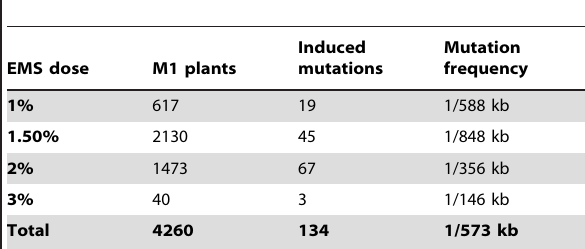
Table 4. Effect of EMS dose on mutation frequency in CharMono mutant